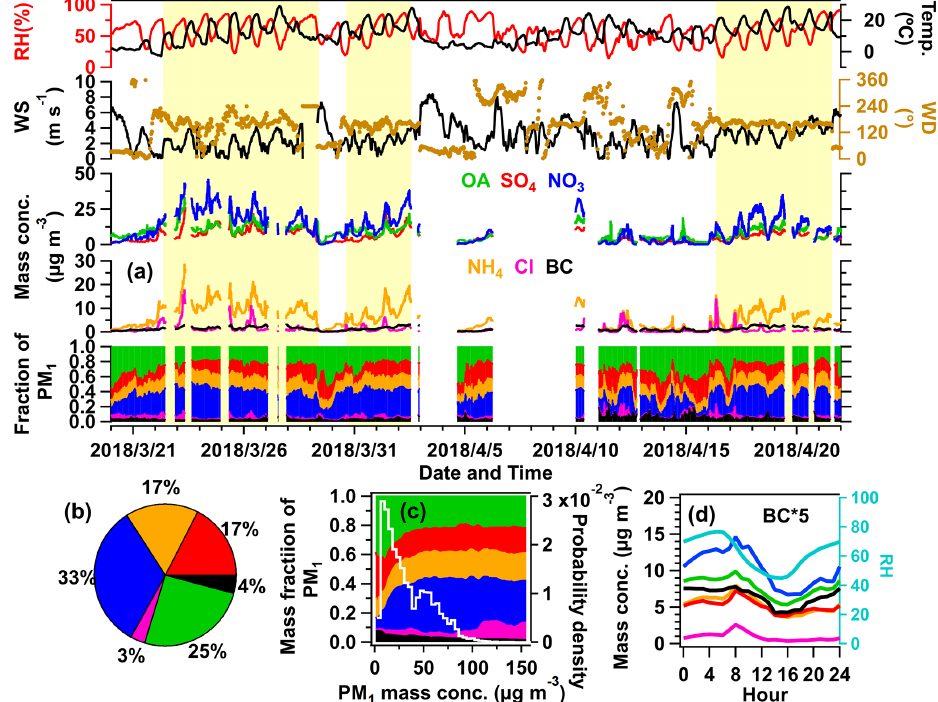
Figure 2. (a) Time series of main species in PM 1 and meteorological parameters (relative humidity, temperature, wind speed, and wind direction). The yellow background represents the polluted period in this campaign, which was selected based on the mass concentration of total PM 1 above 20µgm − 3 , and lasts for at least 2d, accompanied by continuous south winds. (b) Average chemical compositions of PM 1 . (c) Variations of main compositions (left axis) and probability density as a function of PM 1 mass concentration (right axis). (d) Average diurnal variations of PM 1 species and PBL height during the entire campaign.